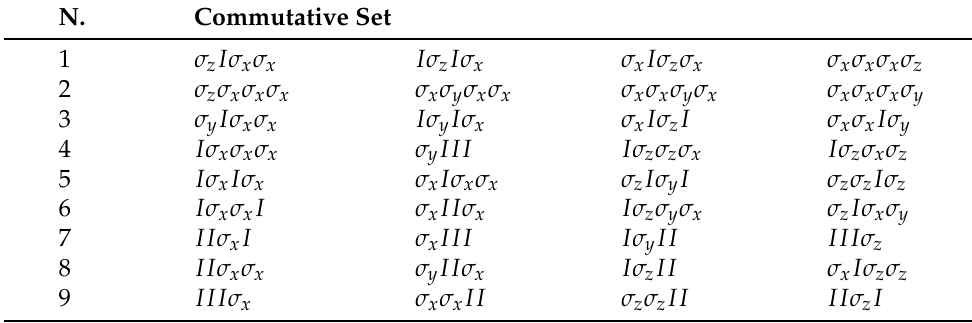
Table 5. Commutative sets (generators) whose eigenstates form a WUS of degree 9.